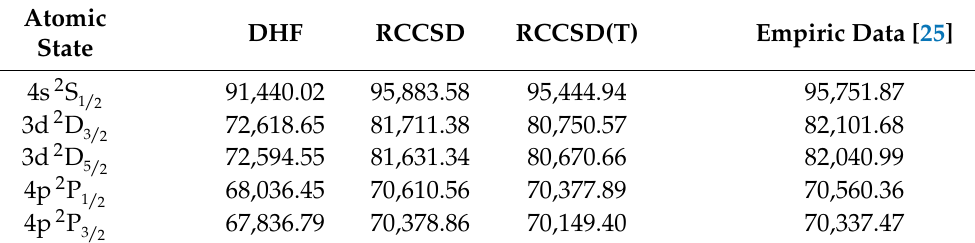
Table 1. Comparison of electron affinity values (in cm − 1 ) from the calculations (as detailed in Section 2 and Equations (3) and (4)) with tabulated data. The latter values are quoted from the NIST database [25]. The three columns for the calculated values correspond to the different methods described in Section